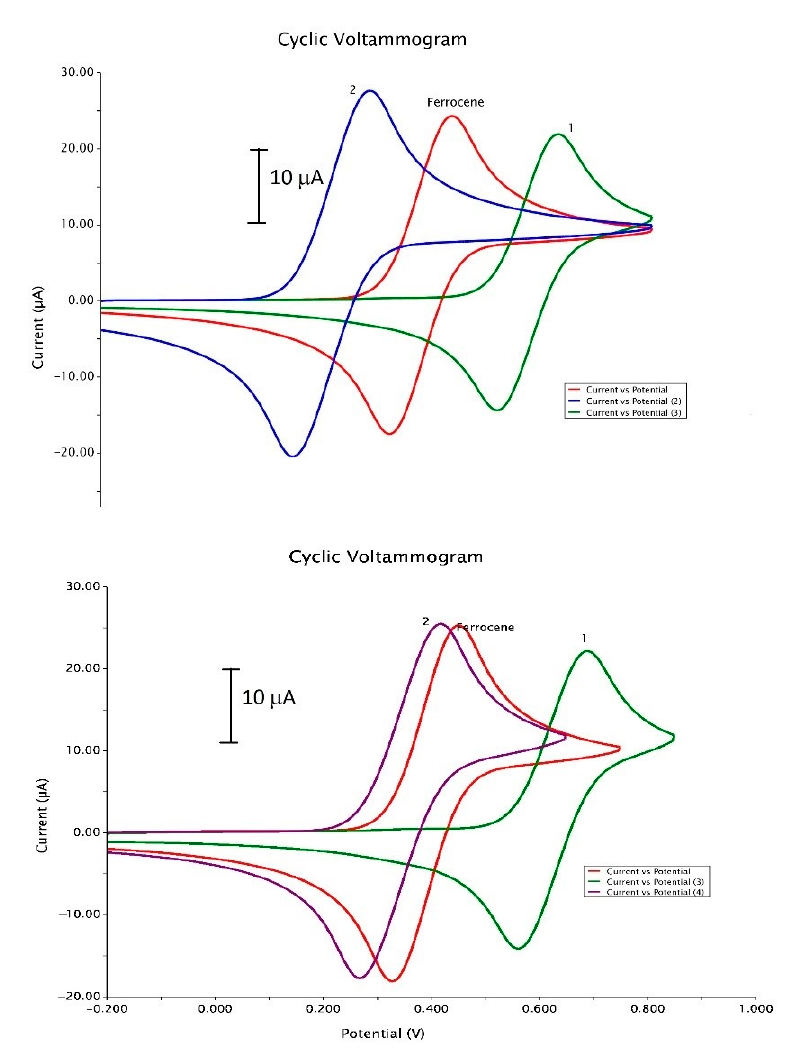
Figure 3. Cyclic voltammograms (scan rate: 100 mV s –1 ) in CH 2 Cl 2 solutions (1.0 mM) at 25 ◦ C (supporting electrolyte n -Bu 4 NPF 6 , 0.1 M), not calibrated. ( Top ): traces from the left 2 , ferrocene, and 1 . ( Bottom ): from the left 2 , ferrocene, and 1 in the presence of n -BuOH. The E 1/2 values roughly correlate with the oxidation potential of metal